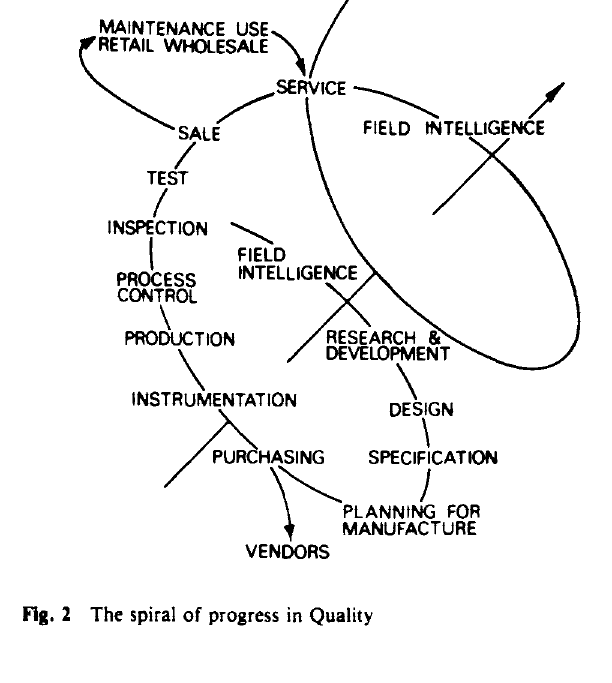
Fig. 2 The spiral of progress in